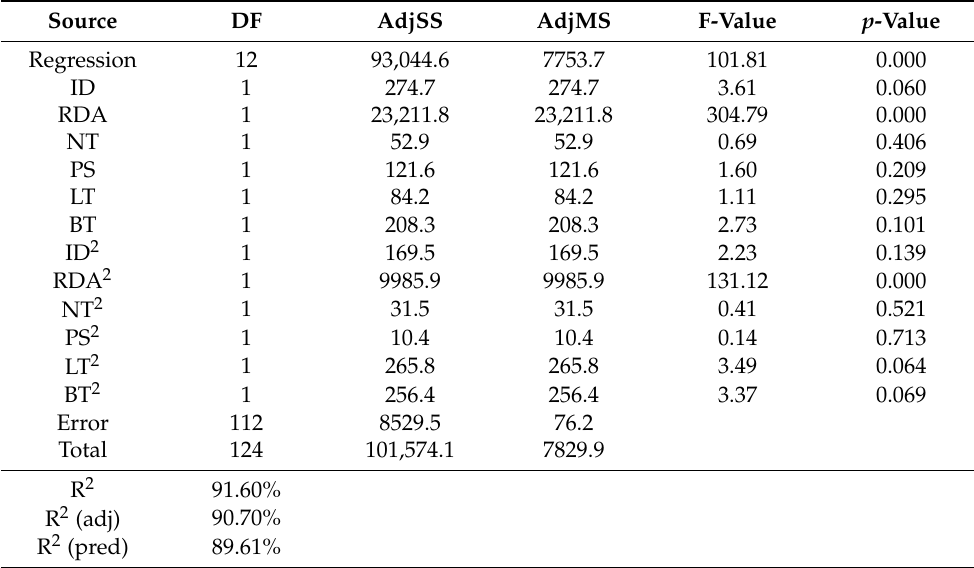
Table 6. Polynomial ANOVA, sB vs. ID, RDA, NT, PS, LT, and BT. Source